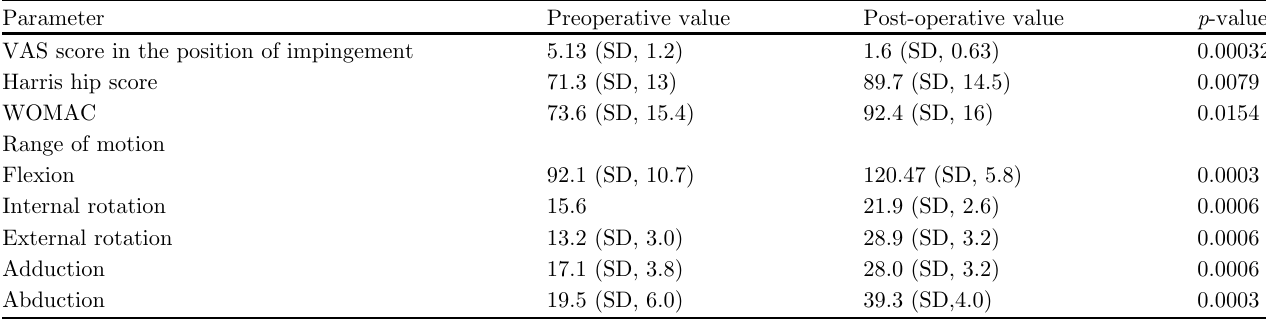
Table 1. Preoperative and post-operative parameters of the patients in this series. There was a statistically signi fi cant difference noticed in all the